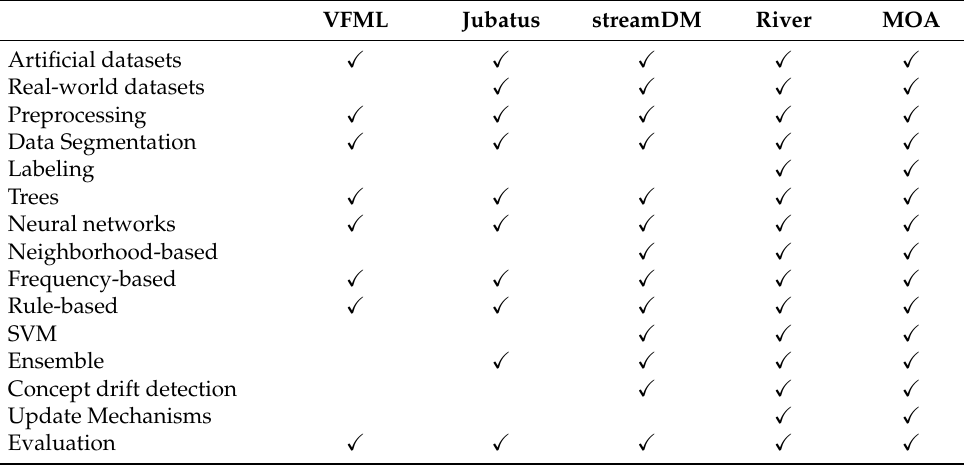
Table 4. Overview of relevant stream classification